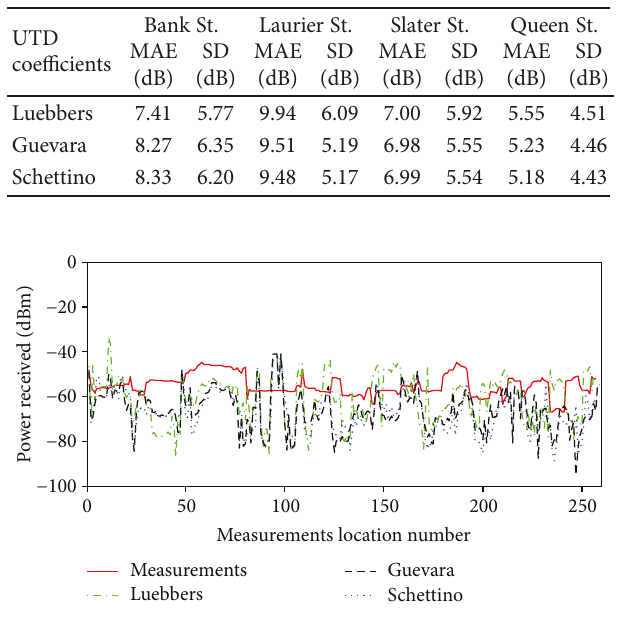
Figure 19: Comparison of model and measured power data for Cali City.